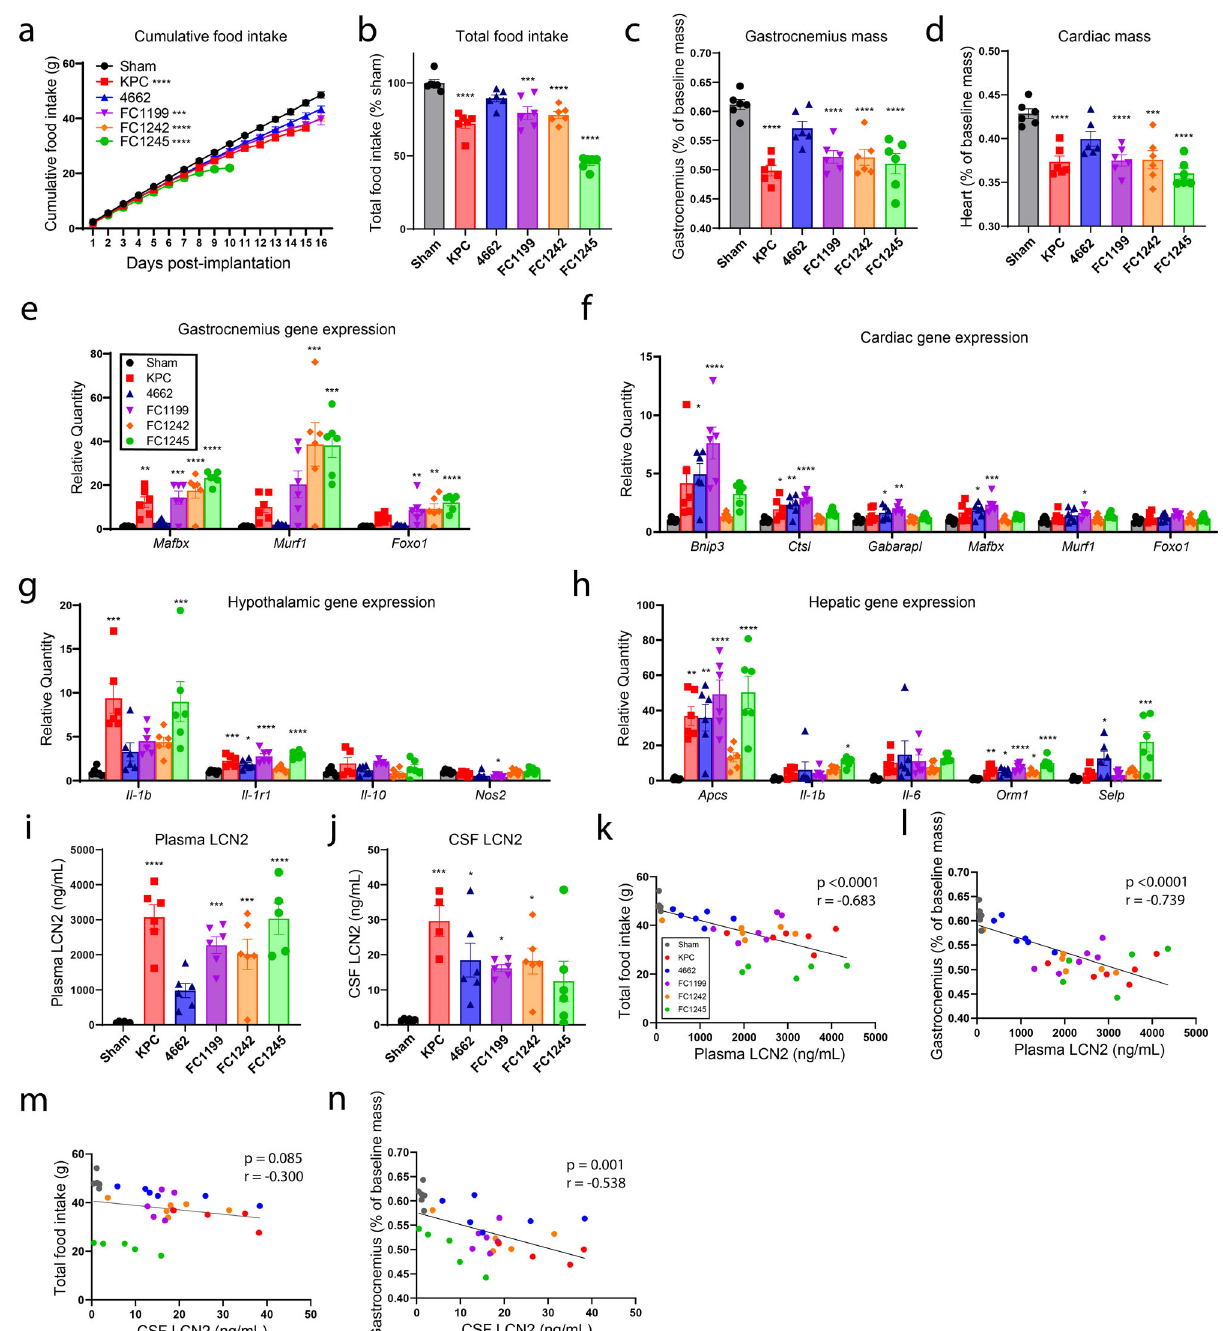
Fig. 1 LCN2 is upregulated across several models of pancreatic cancer cachexia and correlates with food consumption and muscle loss. a Cumulative food intake in fi ve models of pancreatic cancer cachexia and sham operation controls. b Total food intake normalized to sham control group. c Skeletal muscle catabolism as indicated by terminal gastrocnemius mass normalized to body mass. d Cardiac muscle catabolism as indicated by terminal heart mass normalized to body mass. e Gastrocnemius, f heart, g hypothalamus, and h liver gene expression pro fi les in pancreatic cancer cachexia models (represented as relative quantity to sham control). Terminal i plasma and j CSF LCN2 levels. Linear regression analysis between plasma LCN2 levels and k total food intake or l gastrocnemius mass. Linear regression analysis between CSF LCN2 levels and m total food intake or n gastrocnemius mass. a – i , k , l N = 6 per group. j , m , n N = 6 per group except KPC ( N = 4 per group). All data are expressed as mean ± SEM. Data represented in b – j were analyzed with one-way ANOVA with Bonferroni multiple comparisons comparing tumor experimental groups to sham operation control. k – n Analyzed by simple linear regression and two-tailed correlation analyses. * p ≤ 0.05, ** p ≤ 0.01, and *** p ≤ 0.001, **** p ≤ 0.0001. Sham operation controls = gray/black, KPC = red, 4662 = blue, FC1199 = purple, FC1242 = orange, FC1245 = green.